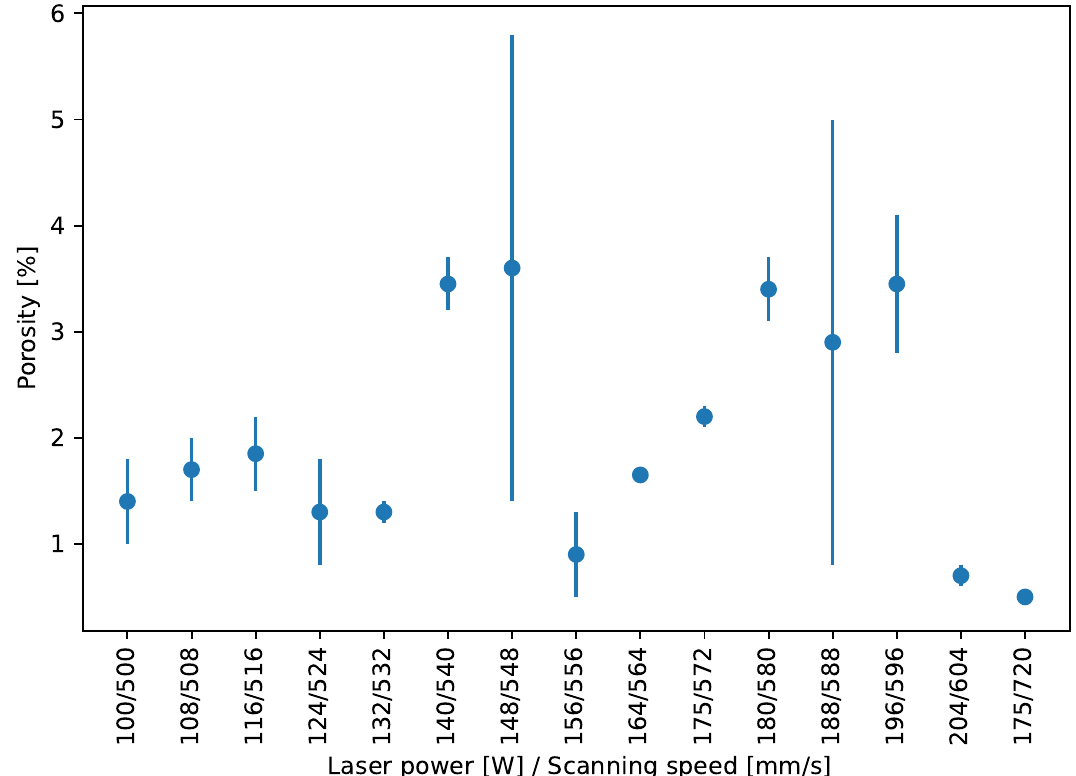
Figure 3. Porosity of printed H13 in dependency of laser power and scanning speed.